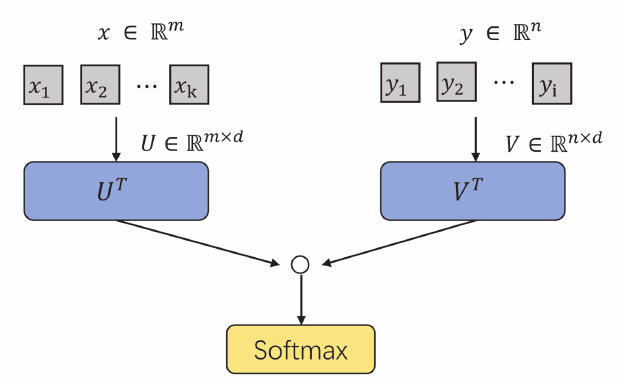
Figure 2. Flowchart of multi-modal factorized bilinear pooling